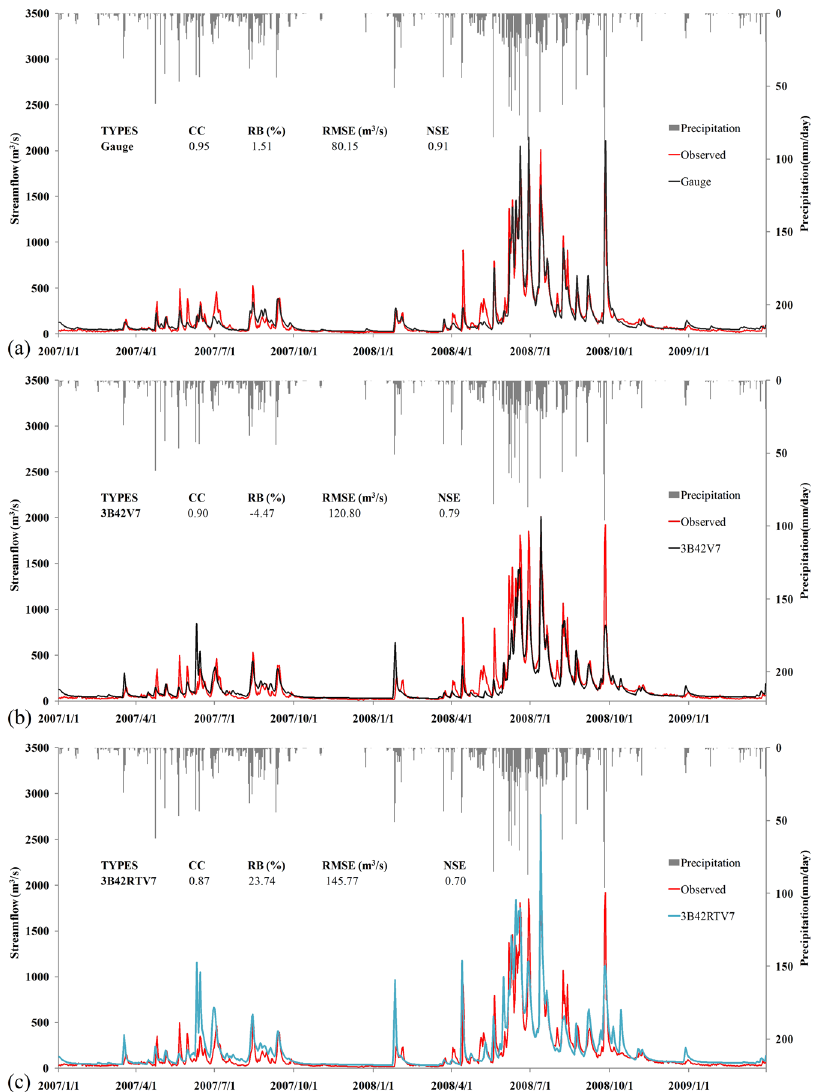
Figure 8. Daily simulation of Nanliu river discharge with inputs from either ( a ) gauge observations, ( b ) 3B42V7 or ( c ) 3B42RTV7. Rainfall inputs (gray bars) from gauge observations are plotted on the secondary ordinate. The red line represents the reference observations of river discharges from the Changle streamflow